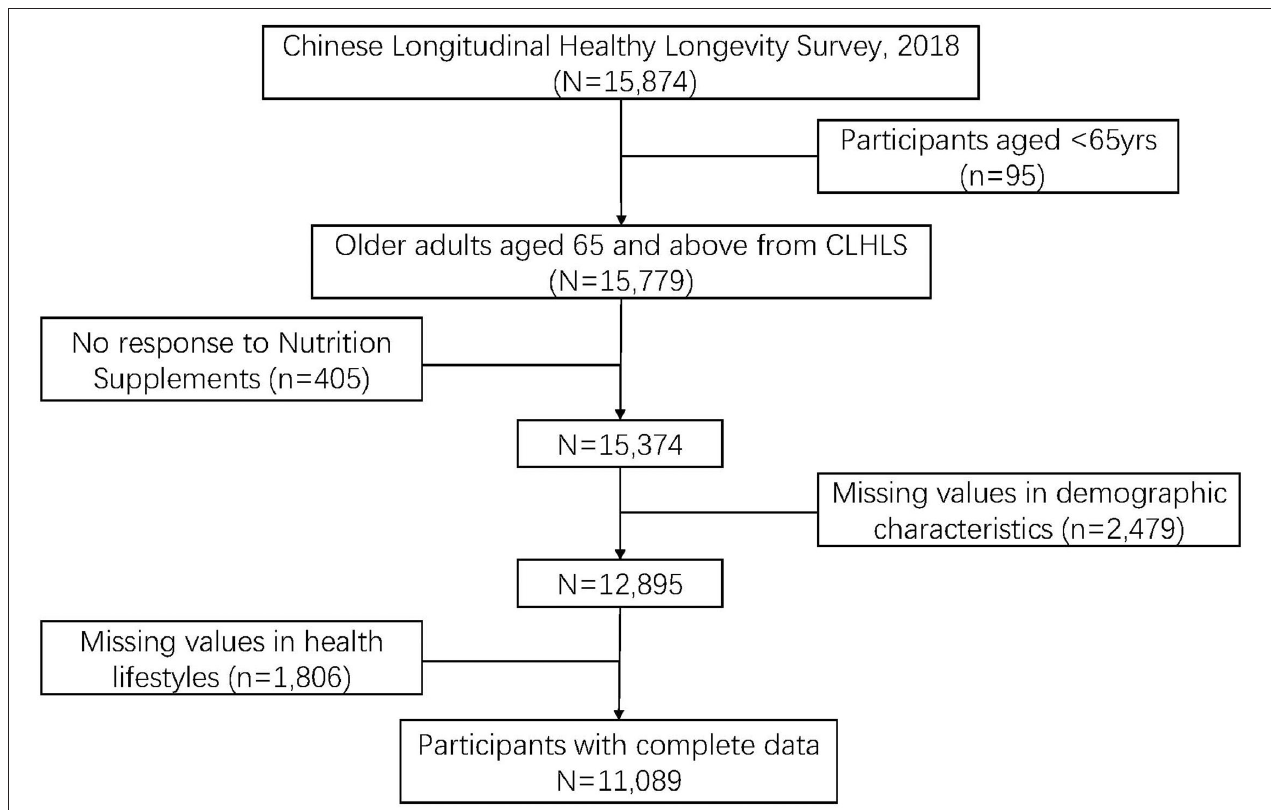
FIGURE 1 | Flowchart of sample screening for study